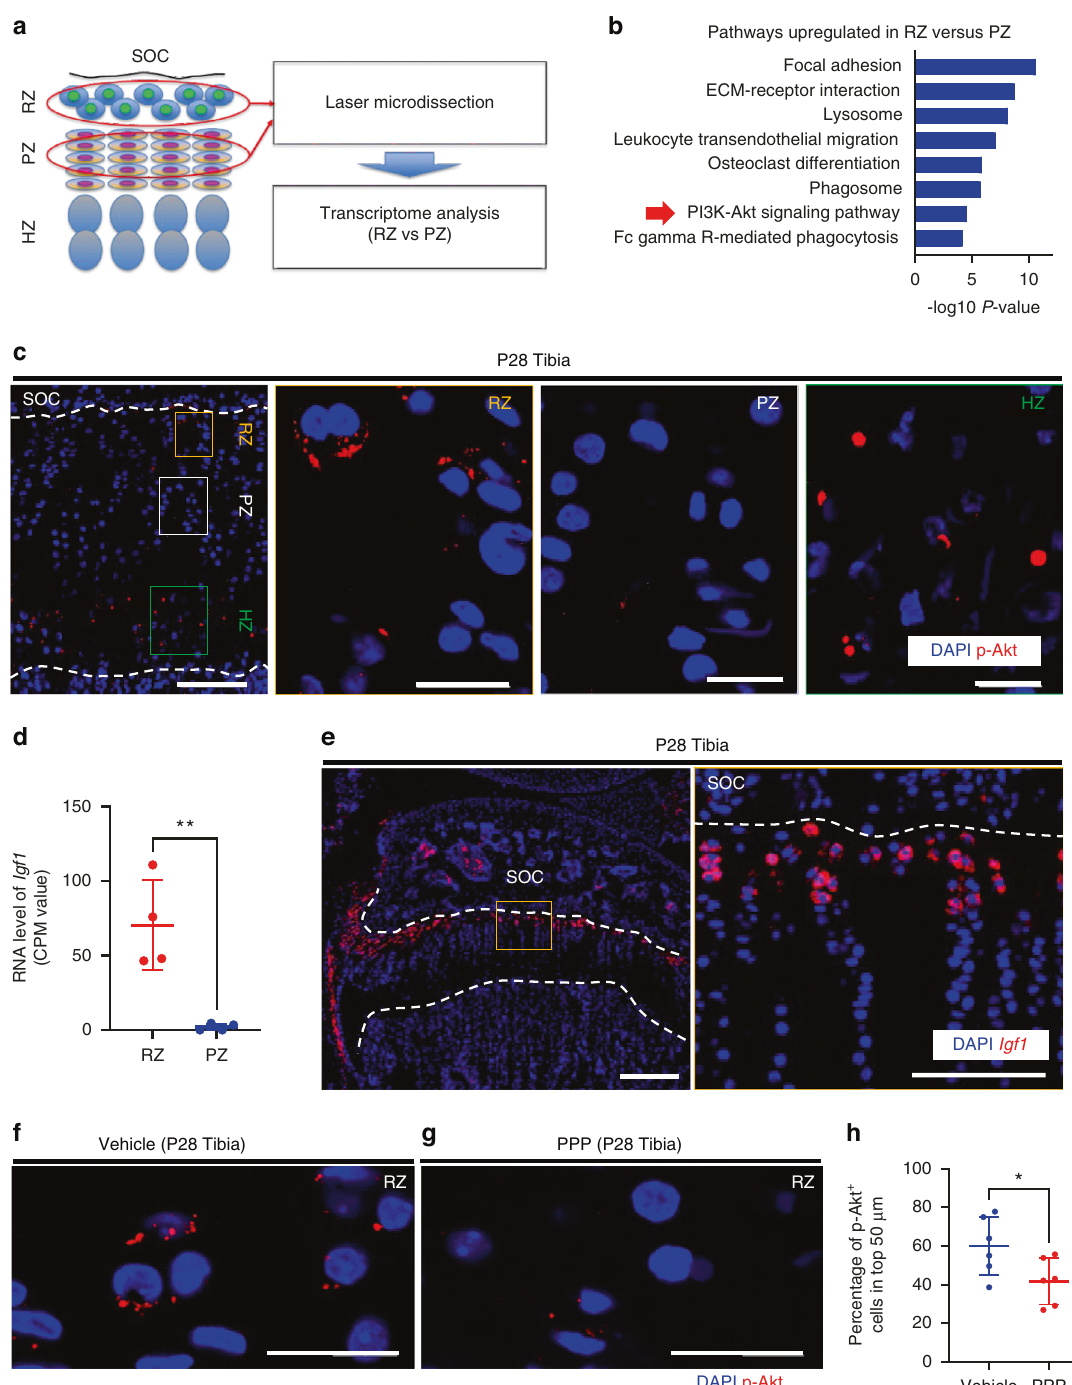
Fig. 5 IGF-1/PI3K signaling is activated in the resting zone. a Schematic diagram for transcriptome analysis using laser microdissection and RNA sequencing. P30 tibial and femoral growth plates in Axin2Cre ERT2 ;R26R TdTomato mice (pulsed on P23 – 25) were subjected to laser microdissection. b KEGG pathways enriched by genes signi fi cantly upregulated in the resting zone compared to the proliferative zone. The red arrow indicates the PI3-Akt signaling pathway. Logarithmic P values of signi fi cance are indicated on the x -axis. c Representative image of immunohistochemistry for p-Akt in the proximal tibial growth plate at P28. The right three panels show magni fi ed views of each zone of the growth plate. d CPM values of Igf-1 in the resting and proliferative zone samples. RZ ( n = 4), PZ ( n = 4). ** P = 0.004 1. e Representative image for in situ hybridization of Igf-1 in the proximal tibial growth plate at P28. The right panel shows a magni fi ed view of the resting zone of the growth plate. f , g Representative image of immunohistochemistry for p-Akt in the resting zone of the proximal-tibial growth plate at P28 after receiving either vehicle (dimethyl sulfoxide/ corn oil, 9:1) ( f ) or IGF-1 receptor tyrosine kinase inhibitor (PPP, 20 μ g·g − 1 body weight) ( g ) 30 min before euthanasia. h Percentage of p-Akt + cells in the top 50 μ m. Vehicle group ( n = 6), PPP group ( n = 6). * P = 0.0435. p-AKT phosphorylation of the protein kinase Akt, SOC secondary ossi fi cation, RZ resting zone, PZ proliferative zone, HZ hypertrophic zone, CPM count per million, PPP picropodophyllin. The white dashed lines demarcate the growth plate from the surrounding tissues. Scale bars: 200 μ m ( c [left-most], e [left]), 100 µm ( e [right]), 20 µm ( c [right three], f , g ). All data are presented as the mean ± SD. Statistical signi fi cance was determined by unpaired two-tailed t